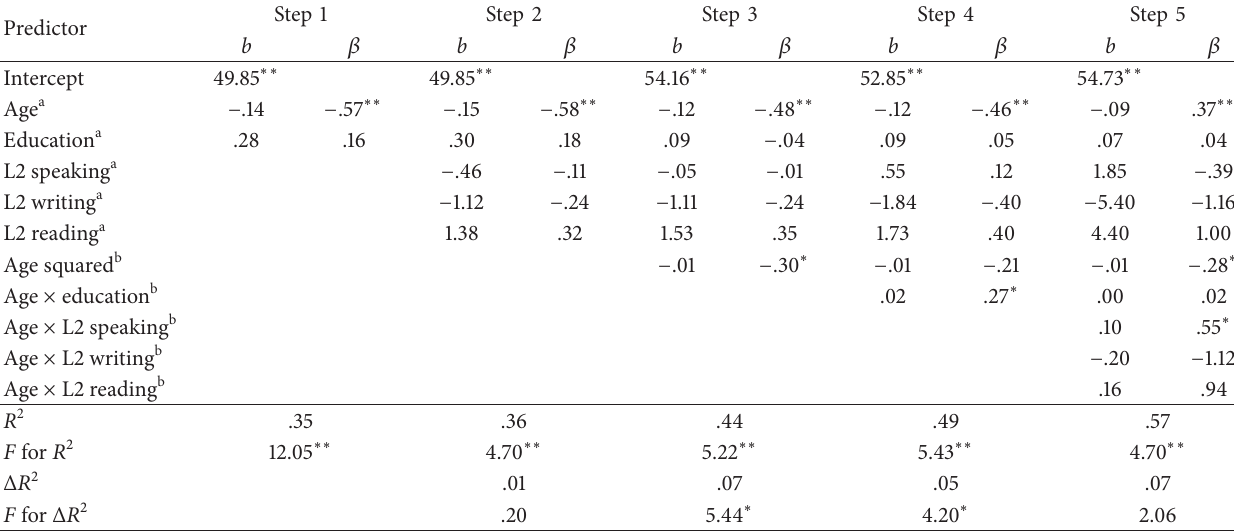
Table 3: Results from the five-step hierarchical multiple regression, predicting